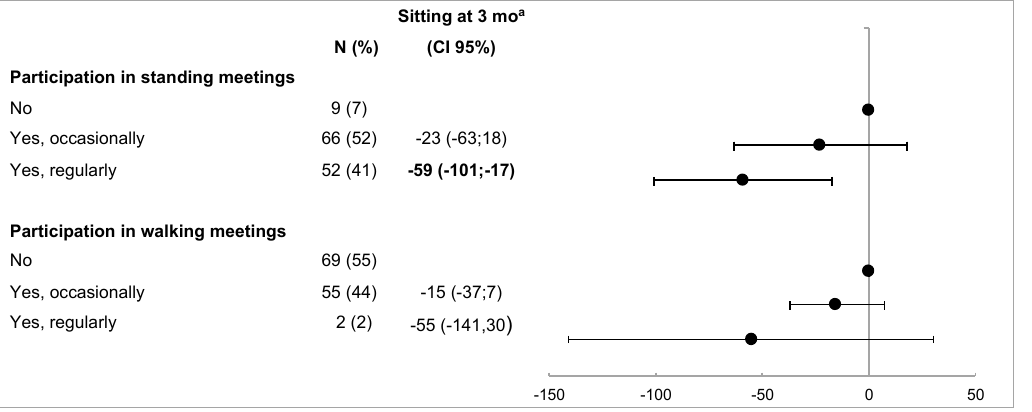
Figure 1. Participation in standing and walking meetings and association with sitting time at 3 months follow-up ( n = 127). Boldface indicates statistical significance ( p = 0.006). a Sitting/8 h workday at 3 months follow-up compared to baseline. The model included participation in standing and walking meetings (exposure); sitting time at 3 months (outcome); and baseline sitting time, age and sex.